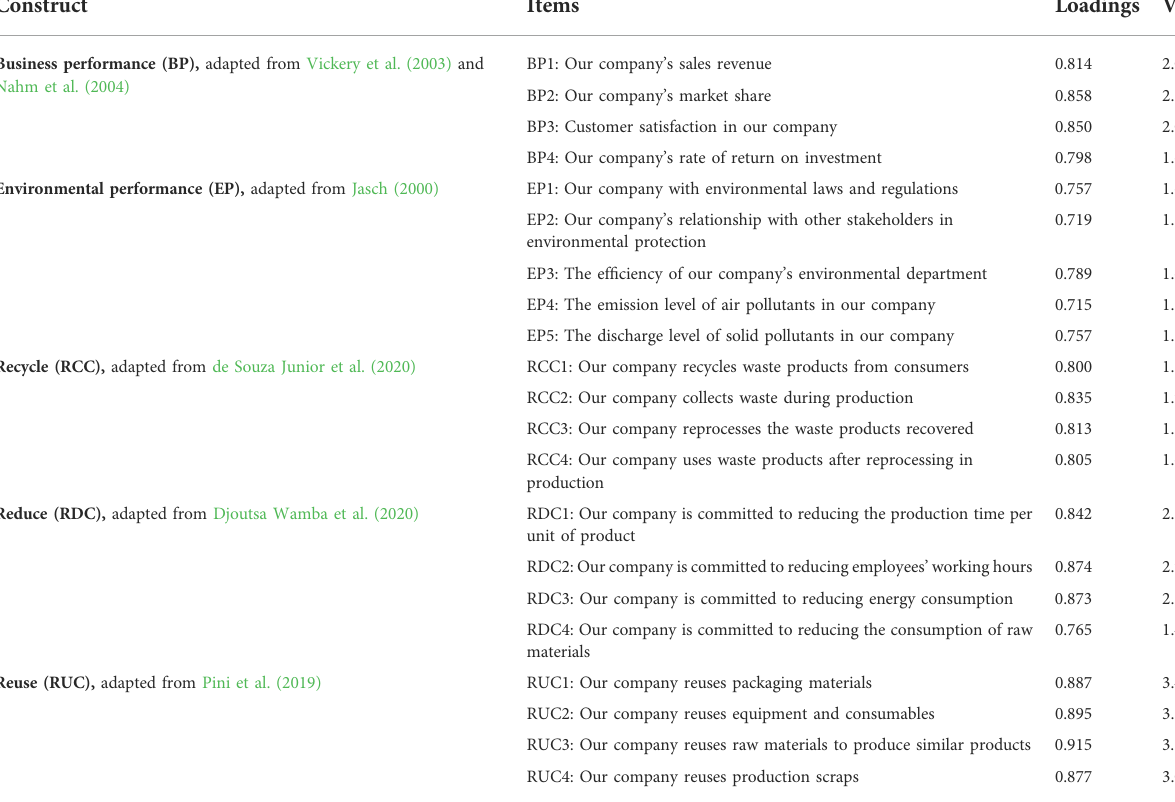
TABLE 2 Items used to measure each survey construct, loadings, and VIF.